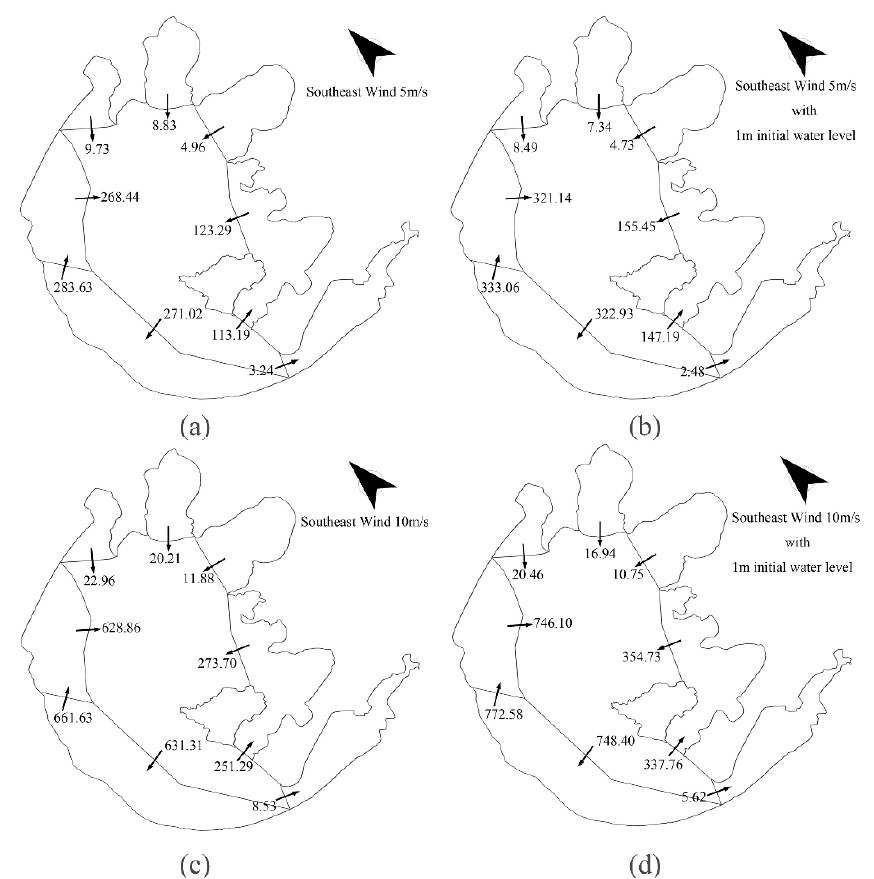
Figure 6. Volume exchange rates between each subbasin with southeast wind. Unit of numbers shown in the figure is m 3 /s; ( a ) 5 m/s southeast wind scenario; ( b ) 5 m/s southeast wind and 1 m initial water level scenario; ( c ) 10 m/s southeast wind scenario; ( d ) 10 m/s southeast wind and 1 m initial water level scenario.